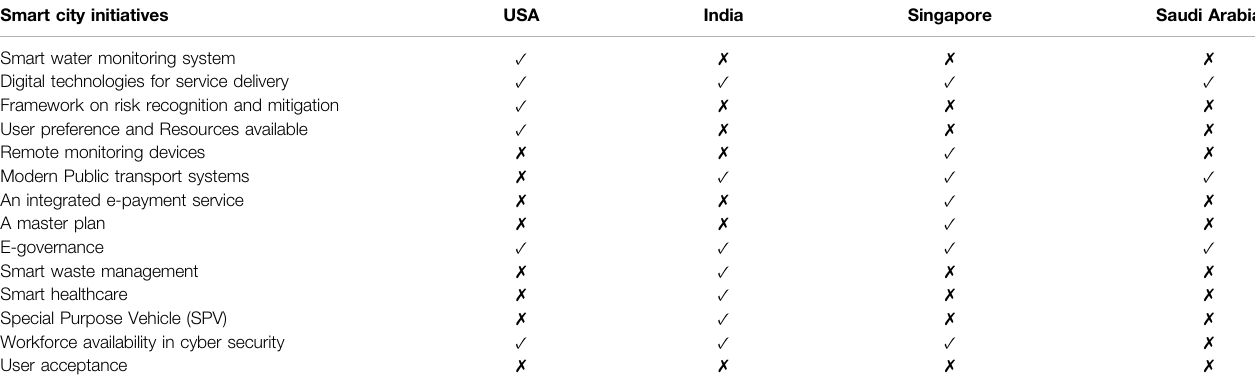
TABLE 1 | Smart city initiatives in the smart cities ’ projects.